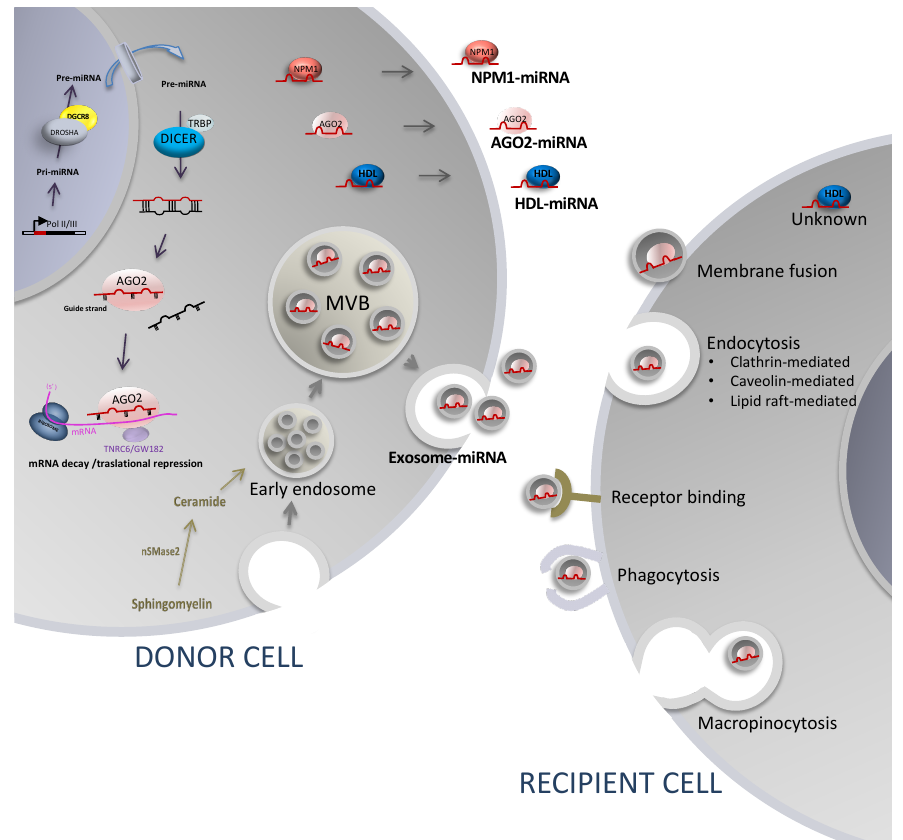
Figure 2. Extracellular miRNA release and uptake mechanisms between cells. miRNAs are released by cells (donor cells) through exosomes or other types of extracellular vesicles (not shown), or by complexing with argonaute 2 (AGO2), high-density lipoprotein (HDL), or nucleophosmin 1